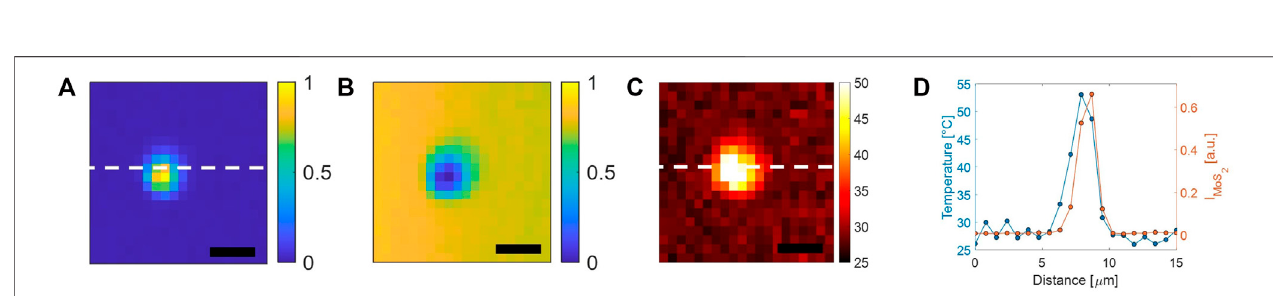
FIGURE6|(A) Ramanmapscorrespondingto I MoS obtainedbyrasterscanningina15- μ m×15- μ mregion(scalebar=4 μ m).Thismaphighlightsthelocalization 2 of the 2D-MoS 2 agglomerate. (B) Intensity I w of the integrated water Raman band in the 3,000- to 3,800-cm − 1 spectral region obtained in the same region analyzed in part A. (C) Temperature map obtained starting from the estimation of the R ratio in the scanned region. (D) Comparison of I MoS cross-sectional lines highlighted in parts A and